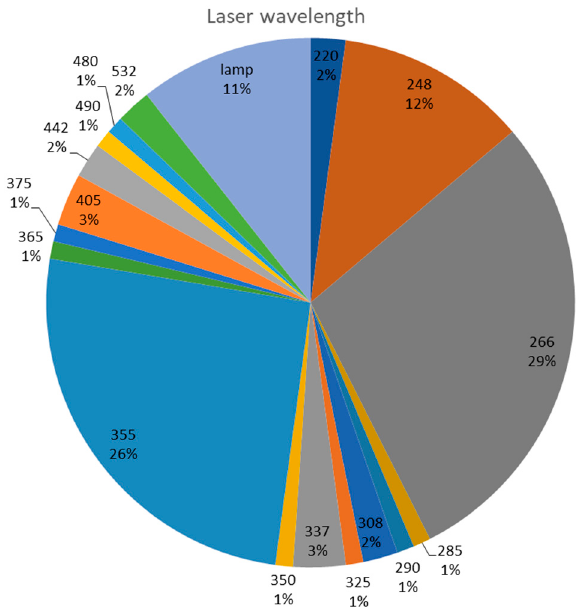
Figure 3. Graphical representation of the predominance of excitation wavelengths encountered in the scientific literature.